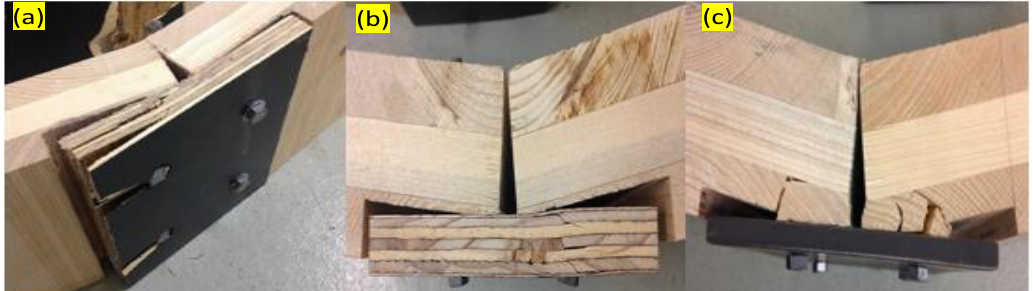
Figure 14. Failure modes of ( a ) glued and bolted plywood, ( b ) unglued and bolted plywood and ( c ) 8mm-thick steel spline connection.